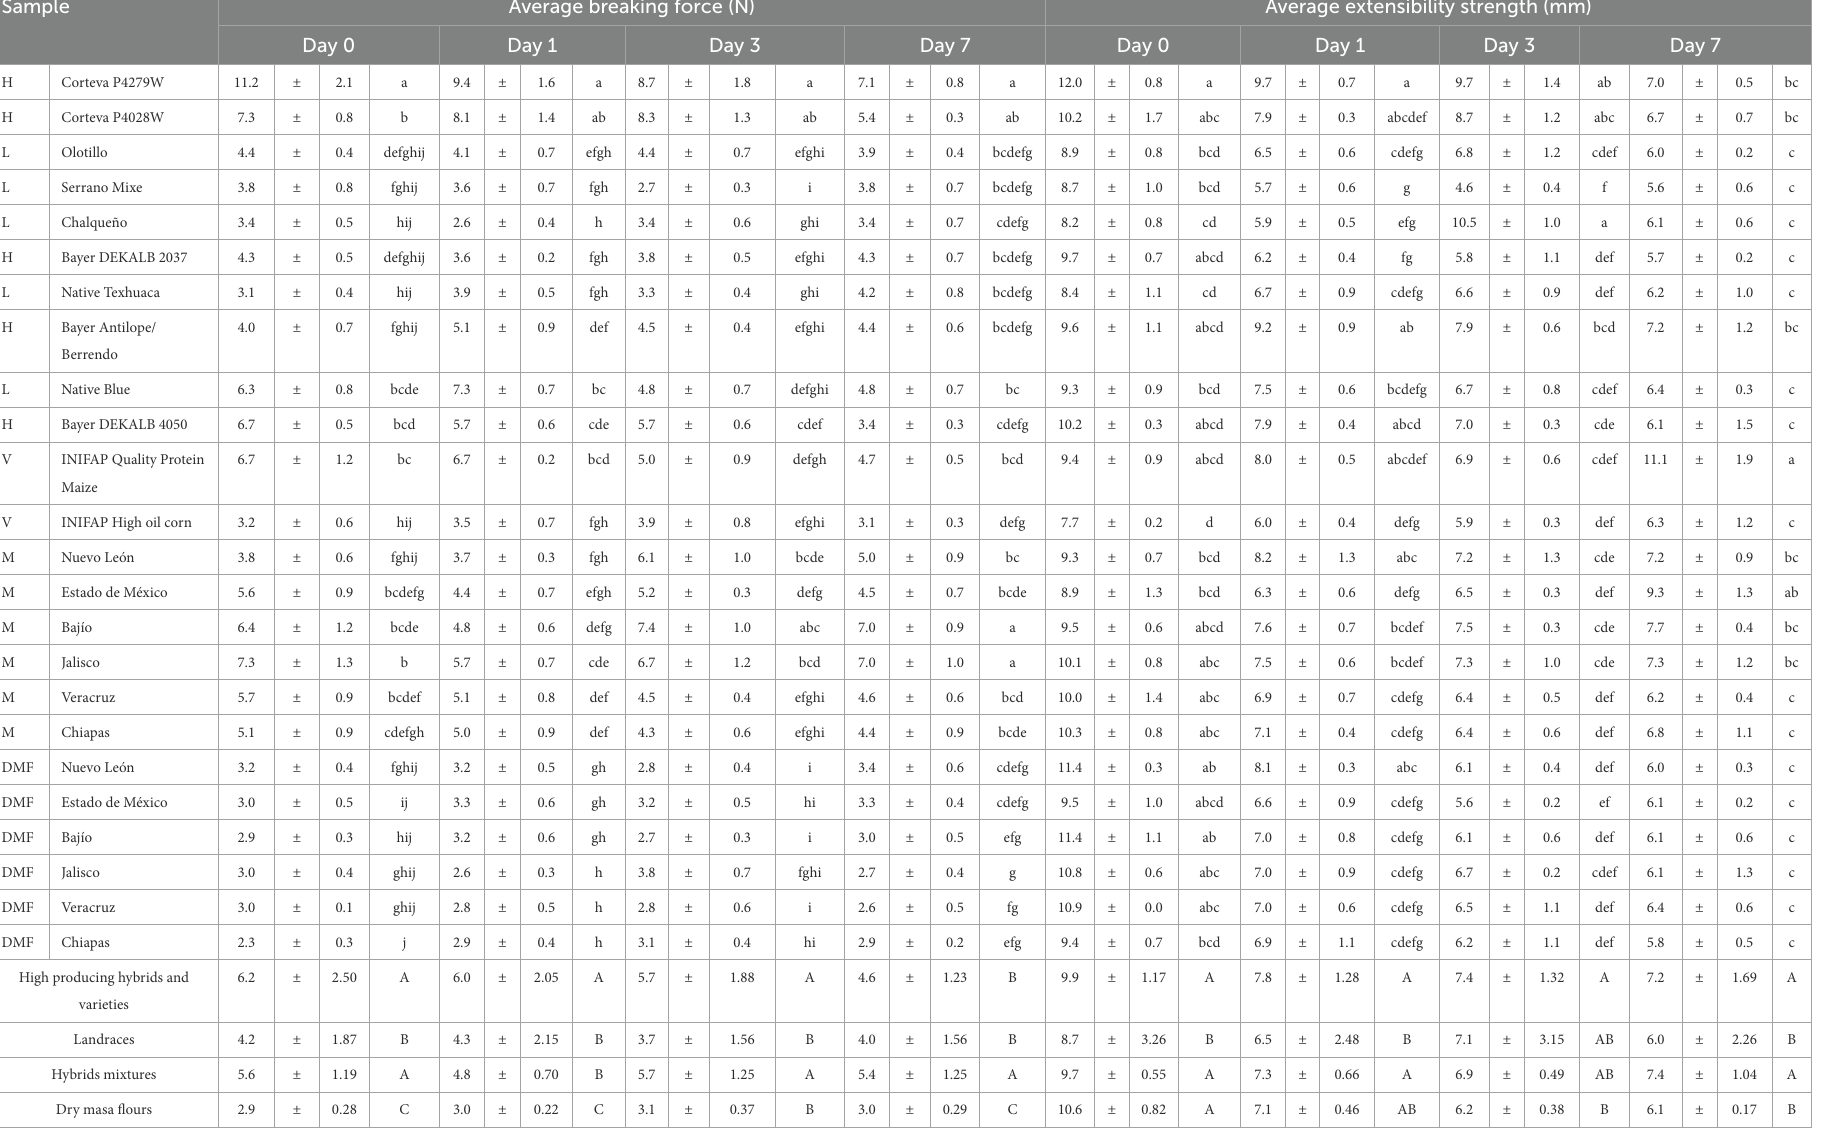
TABLE 6 Characteristics of tortilla quality: